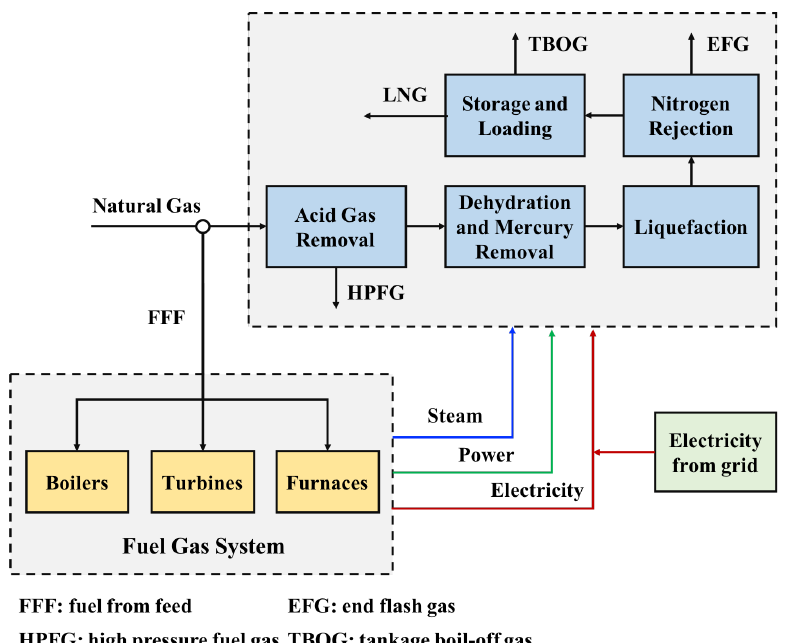
Figure 6. Process diagram for a conventional LNG